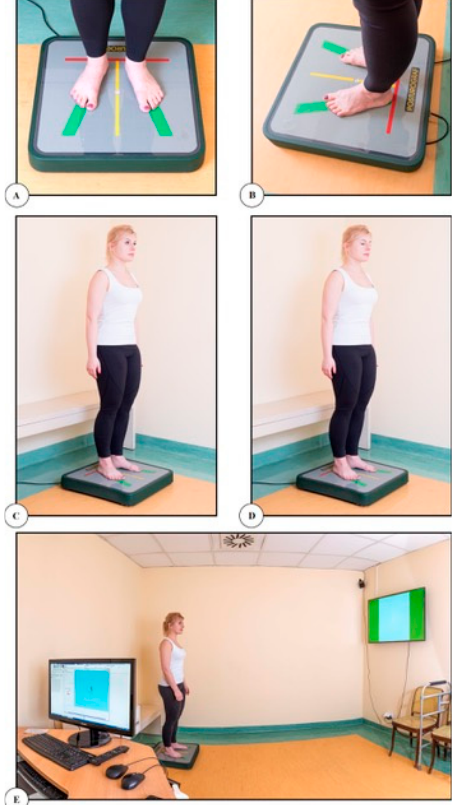
Figure 1. Stability measurement on a stable platform: ( A ) placement of feet (front view); ( B ) placement of feet (side view); ( C ) test with open eyes; ( D ) test with closed eyes; ( E ) test with visual feedback.